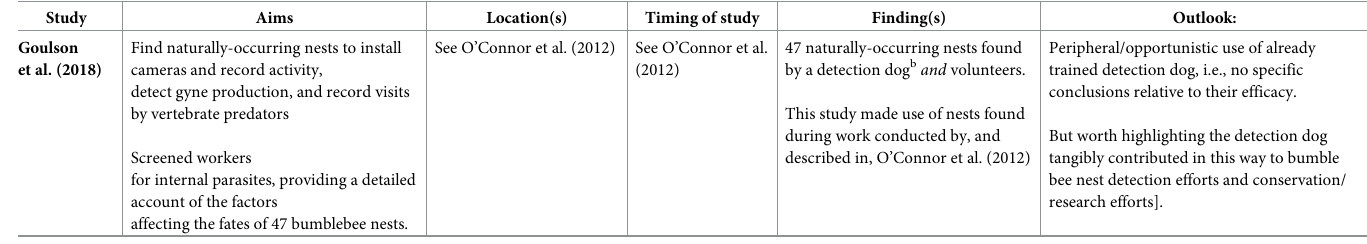
S1 Table. Detection dog session parameters during on-site and in-situ training in Ontario, Canada (June 24 –July 5, 2019). Summary of work session parameters of the dog-handler teams, which depended on the prevailing weather conditions, to capitalize on cooler tempera- tures and reduce heat stress opportunities on the dogs. The session timeframes and tempera-